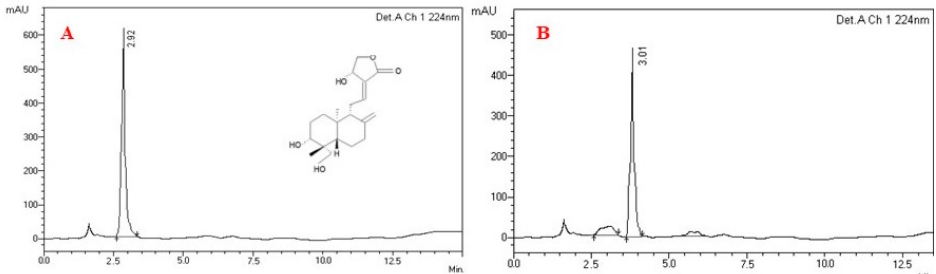
Figure 1. High-performance liquid chromatography (HPLC) chromatogram of standard andrographolide ( A ) along with their chemical structure; ( B ) isolated compound andrographolide.